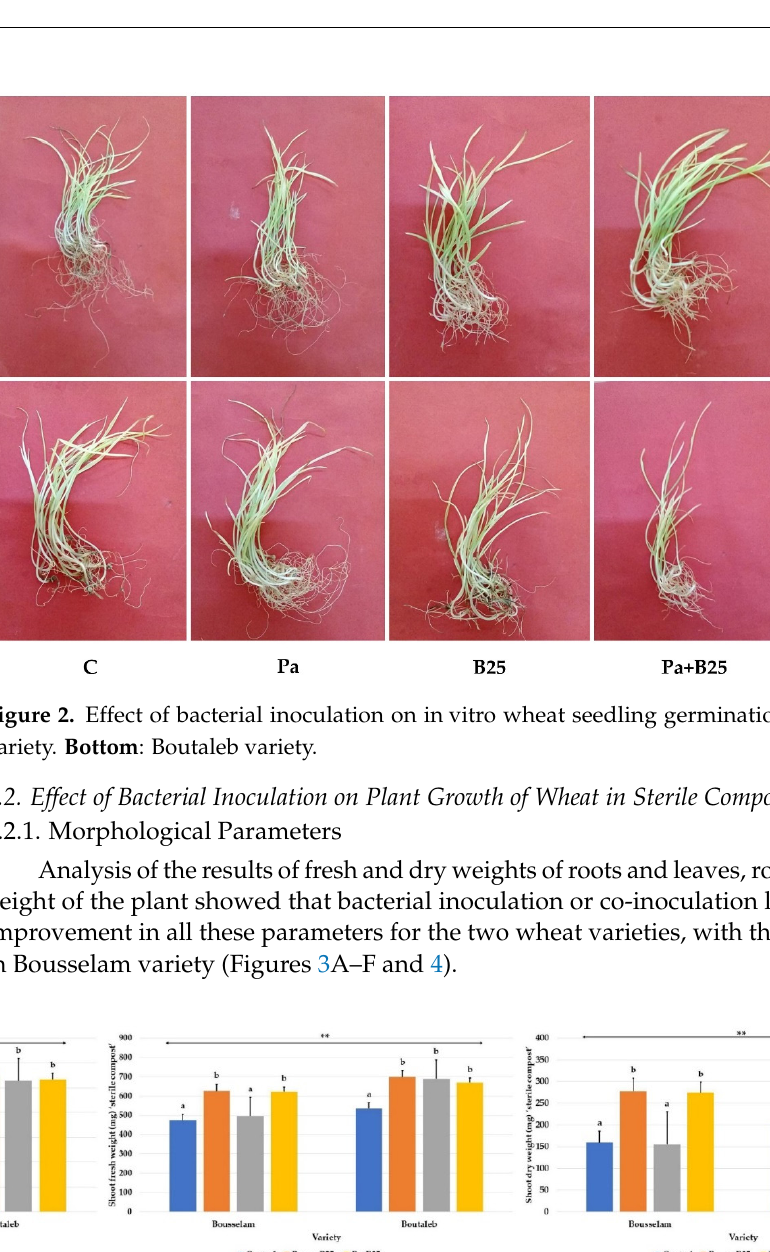
Figure 3. Effect of bacterial inoculation on ( A , B ) shoot and root length (cm), ( C , D ) shoot and root fresh weight (g), and ( E , F ) shoot and root dry weight of wheat plants grown in sterile compost of Bousselam and Boutaleb varieties. The bar plots represent the mean ± standard error of three differ- ent experiments. IBM SPSS Statistics v.24 was used to perform statistical analysis, using a two-way ANOVA and Tukey’s multiple comparison post-test. Significant differences are displayed as: * p < 0.05, ** p < 0.01. ns: non-significant.